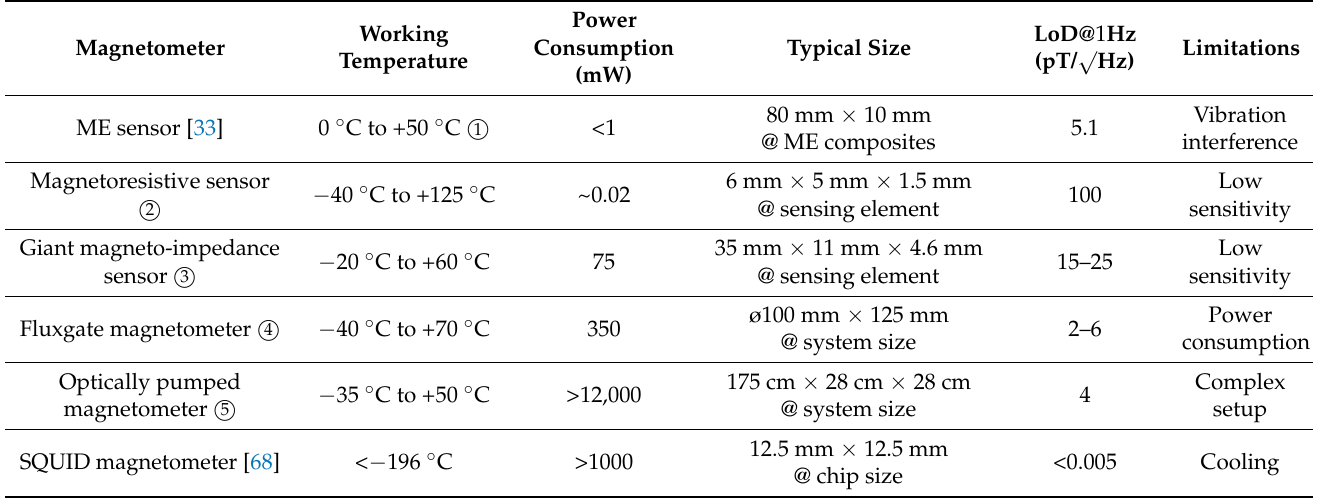
Table 3. Performance Comparison with commercially available magnetometer for 1 Hz magnetic field sensing.